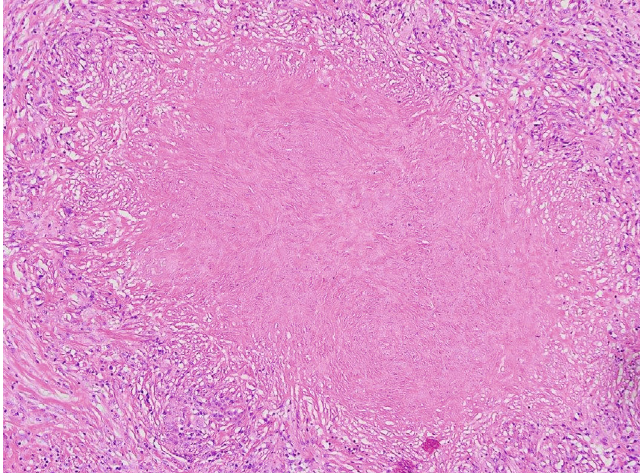
Figure 4: Hematoxylin and eosin stain of surgical biopsy showing multiple necrotizing granulomas, some of which are surrounded by organizing pneumonia.